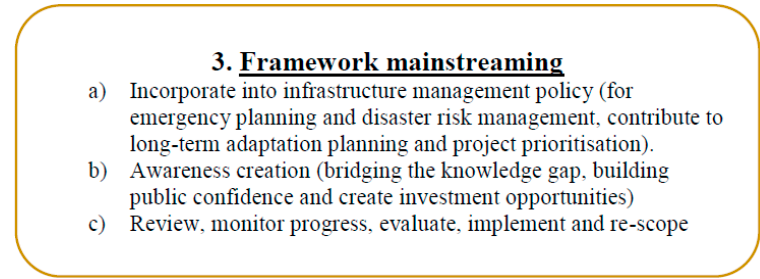
Figure 4. Mainstreaming vulnerability assessment into policy making system.